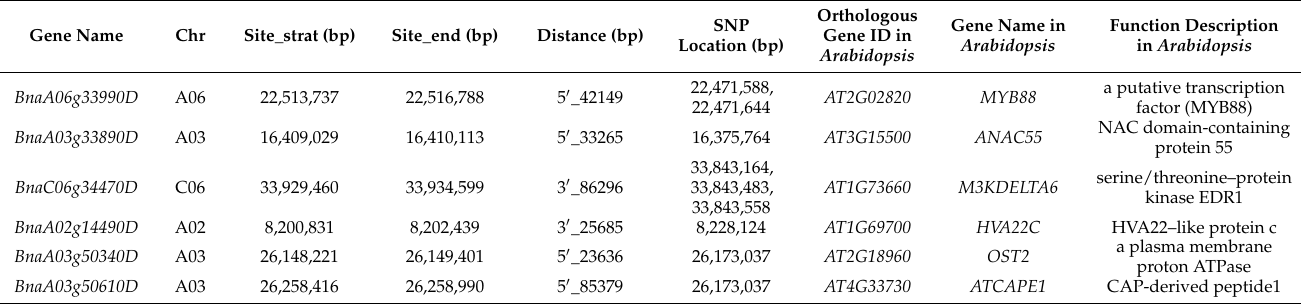
Table 3. The candidate genes controlling both salt tolerance and